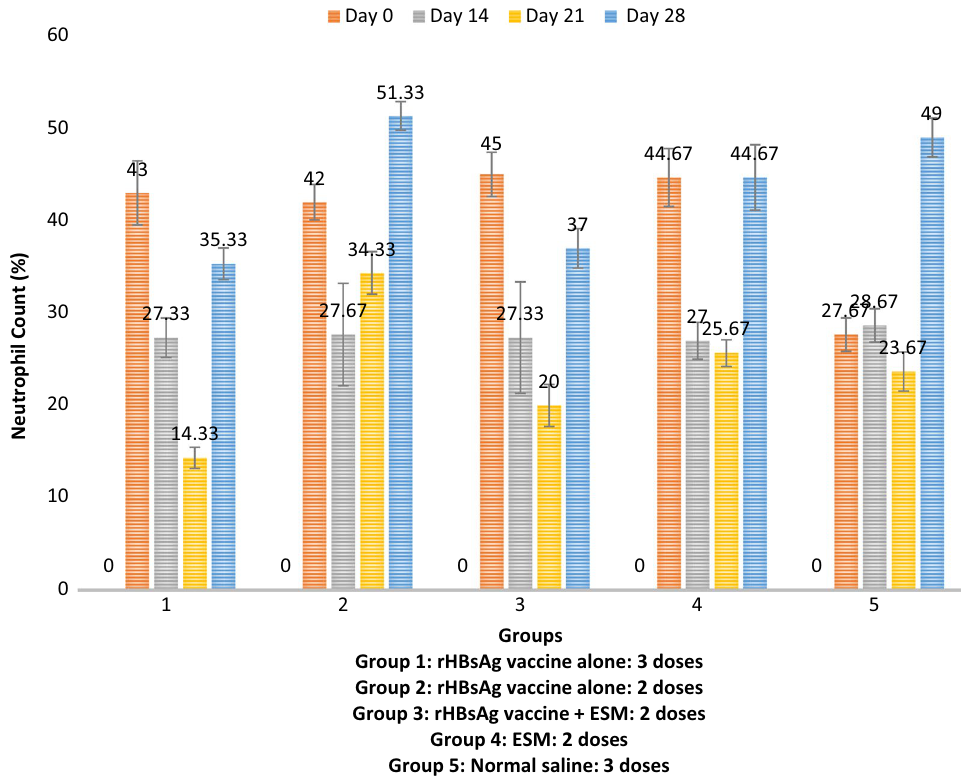
Fig. 1 Neutrophil count from the differential WBC analysis across the experimental